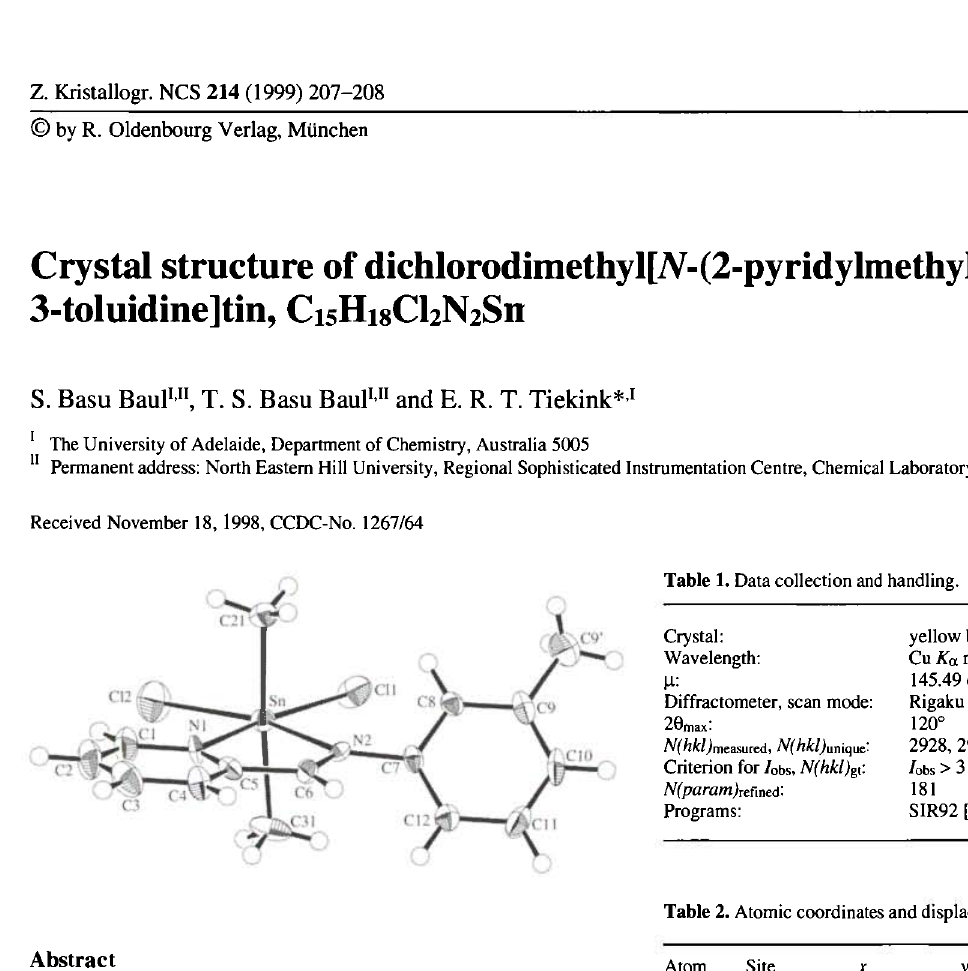
Table 2. Atomic coordinates and displacement parameters (in Ä 2 ).